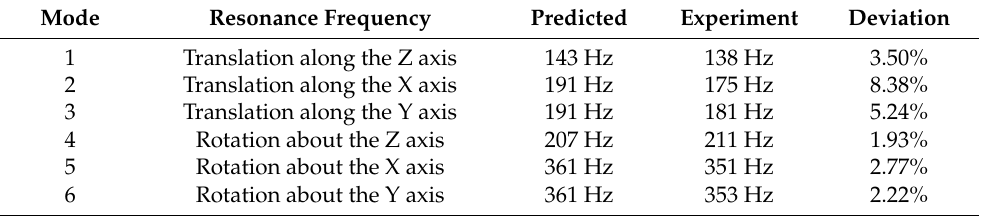
Table 2. Deviations between the experimental dynamic responses compared against the predicted values. Mode Resonance